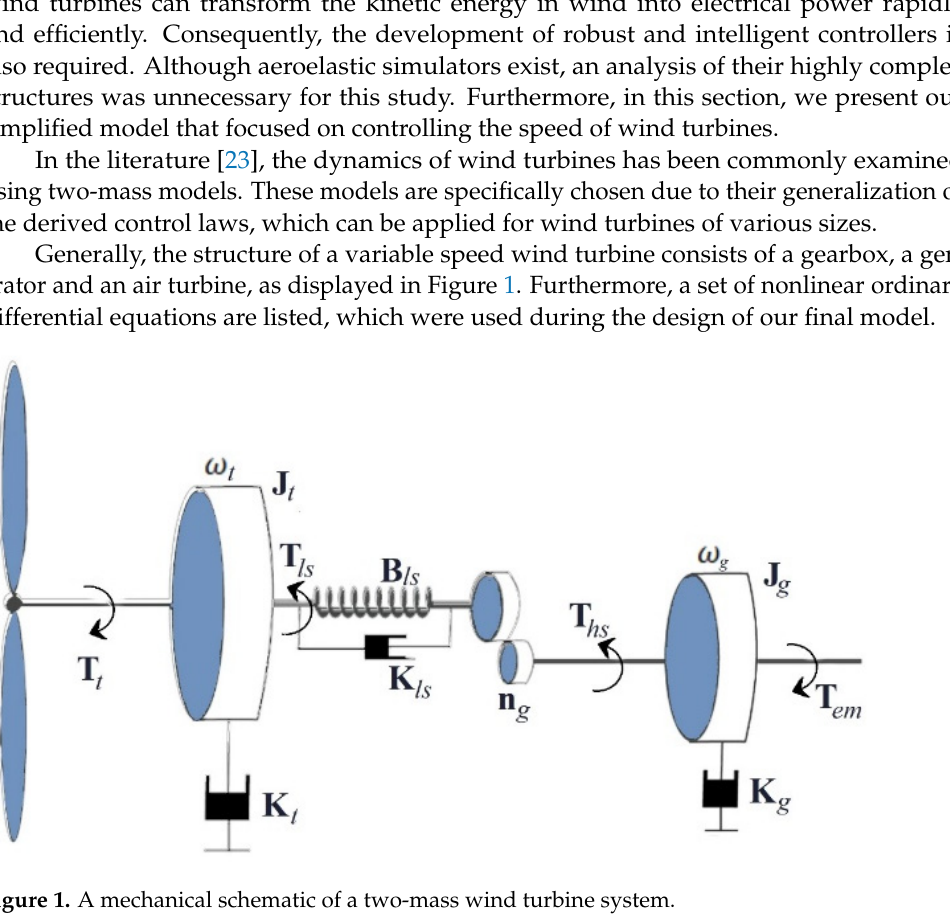
Figure 1. A mechanical schematic of a two-mass wind turbine system .